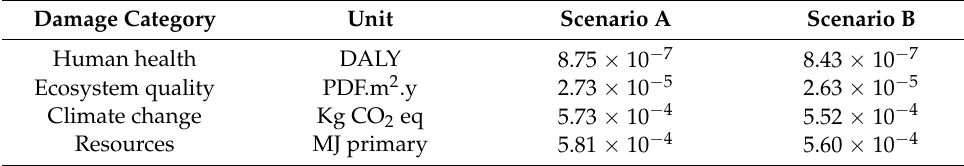
Table 3. Normalized values for each environmental damage category.